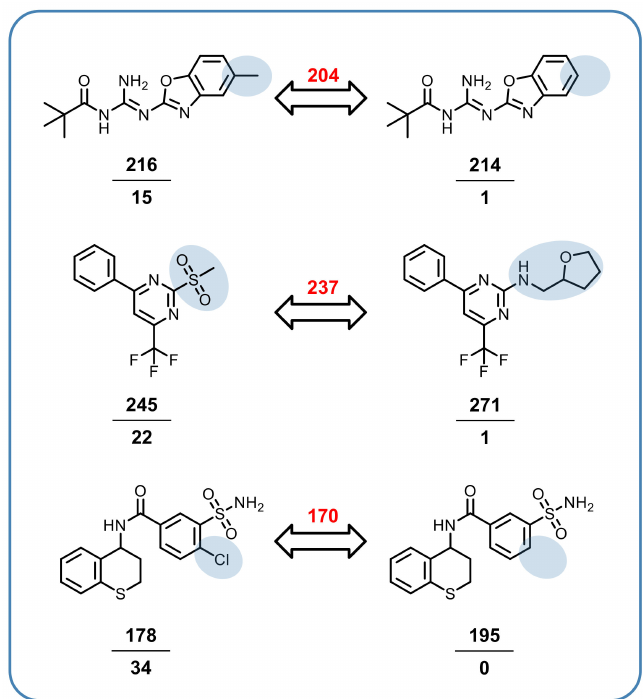
Figure 4. Three exemplary promiscuity cliffs (PCs) formed by multiclass ligands (left) and non-promiscuous or consistently inactive screening compounds (right) are shown. Structural modifications are highlighted. Below each compound, the number of targets it was tested (top) and active against (bottom) is given. Red numbers above arrows report shared tested targets. For example, the PC at the bottom of the figure consisted of a multiclass ligand that was tested against 178 targets and active against 34 of them and a compound that was consistently inactive against all 195 targets it was tested against. These two compounds, which were only distinguished by a chlorine substitution, were tested against 170 shared targets.